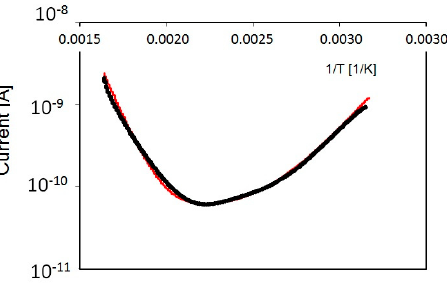
Figure 8. Current measured as a function of reciprocal temperature during a quasi-stationary heating process, in the range 300–600 K with no priming. Dark: data, red: best-fit.